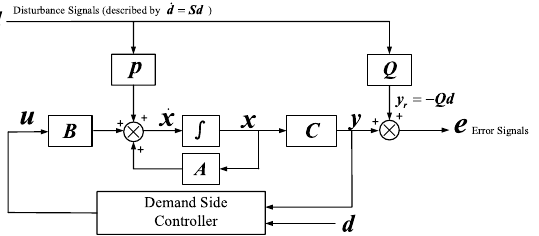
Fig.5 Block diagram of the demand side control